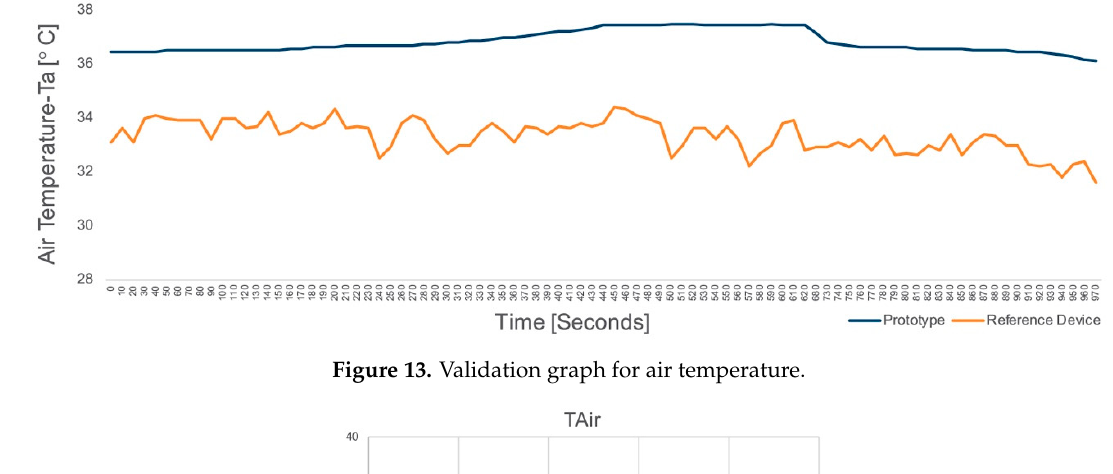
Figure 12. The linear regression graph for globe temperature.